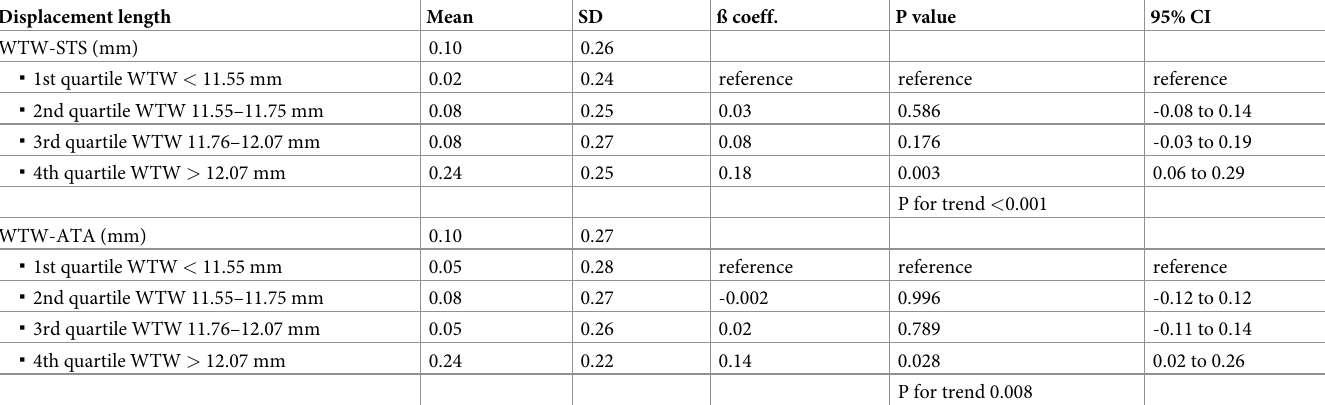
Table 2. Displacement length for the four categories by white-to-white distance in